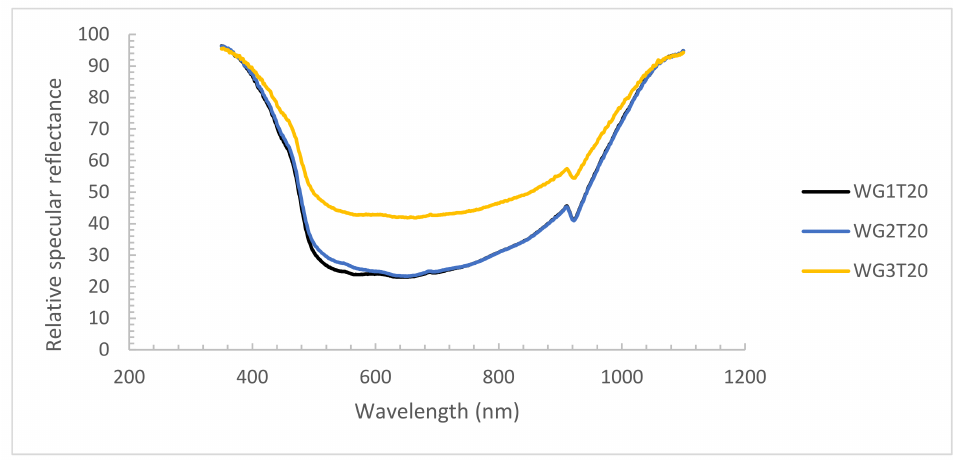
Figure 5. Specular light reflectance of the first set of specimens fired at 1000 ◦ C during 20 min.